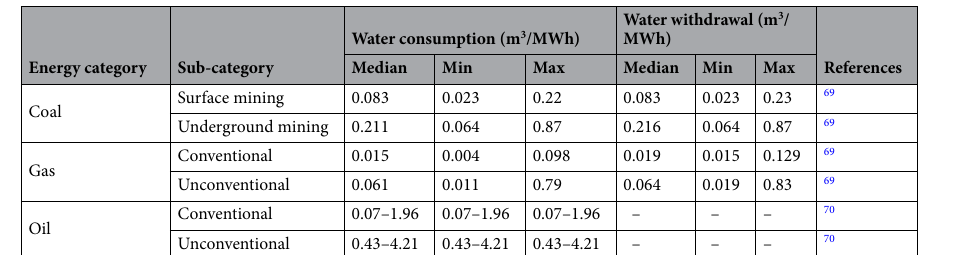
Table 3. Water withdrawal and consumption data per unit of energy.